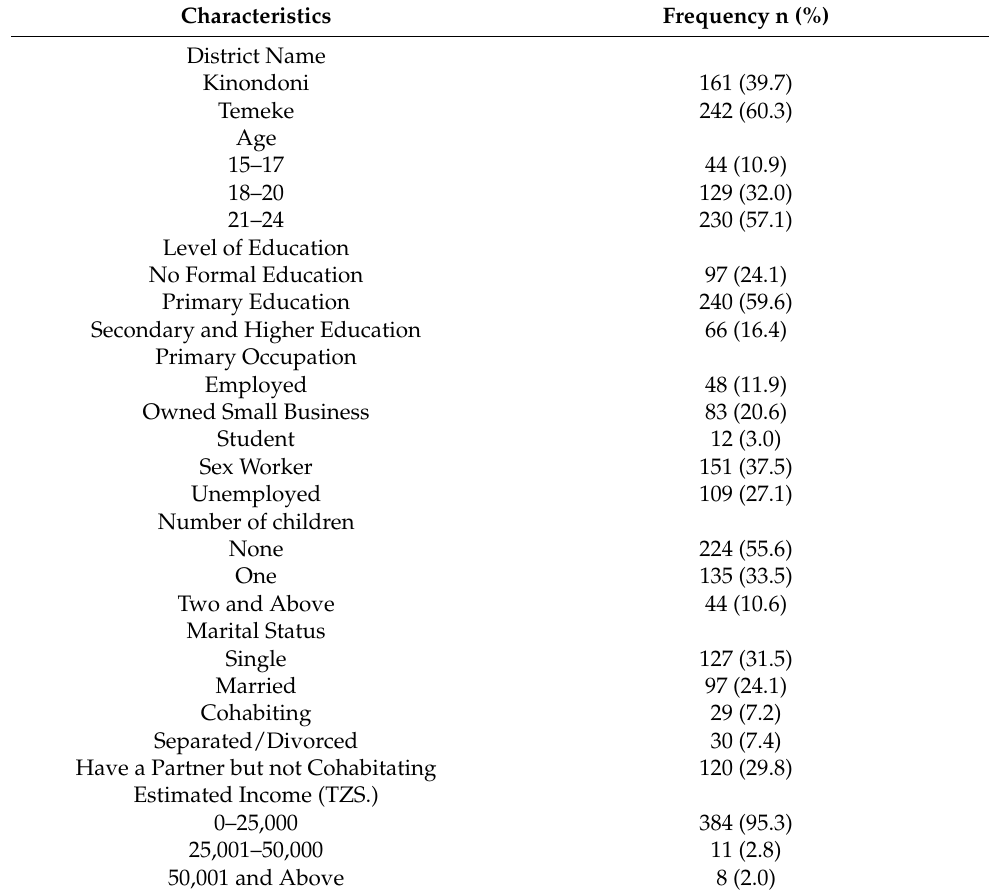
Table 1. Socio-demographic characteristics of participants (n =